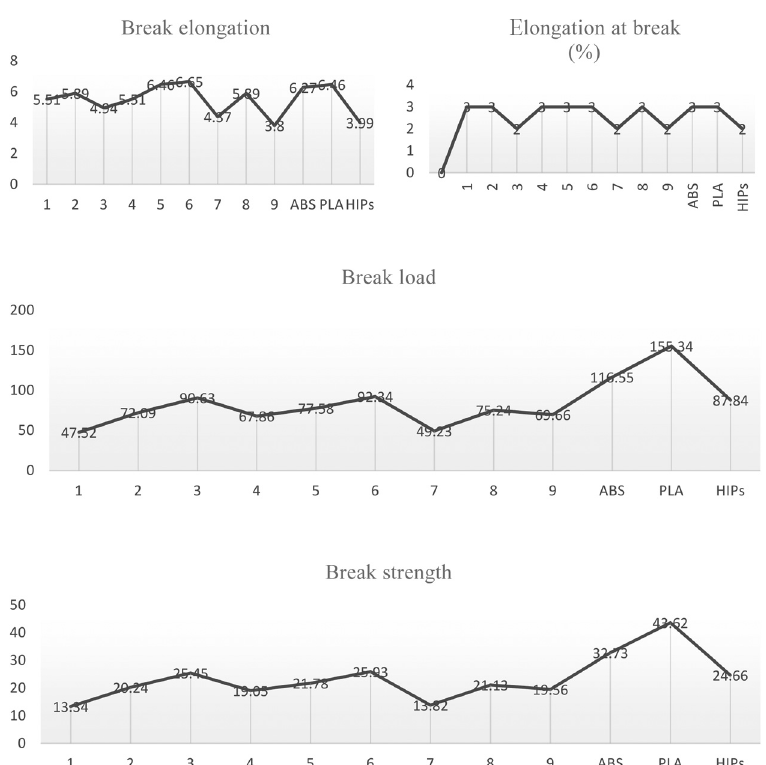
Figure 14. Pull out properties